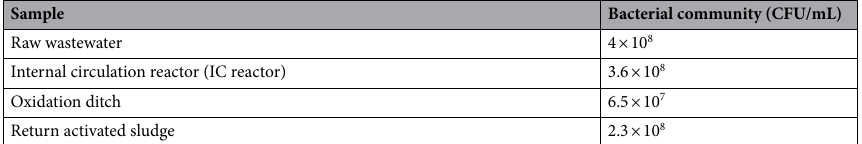
Table 3. Bacterial community (CFU/mL) in RPCM-WWTP. RPCM, recycled paper and cardboard mill; WWTP, wastewater treatment plant.